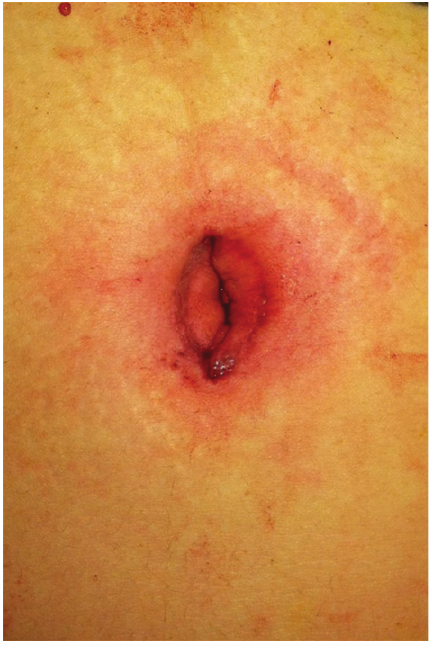
Figure 7: Postoperative